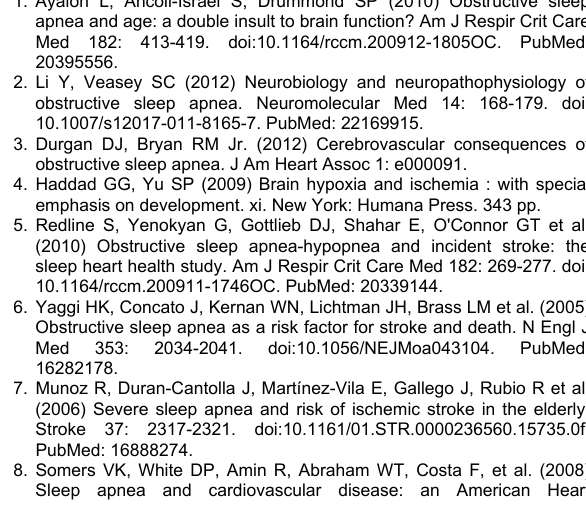
Table S2. Interregional